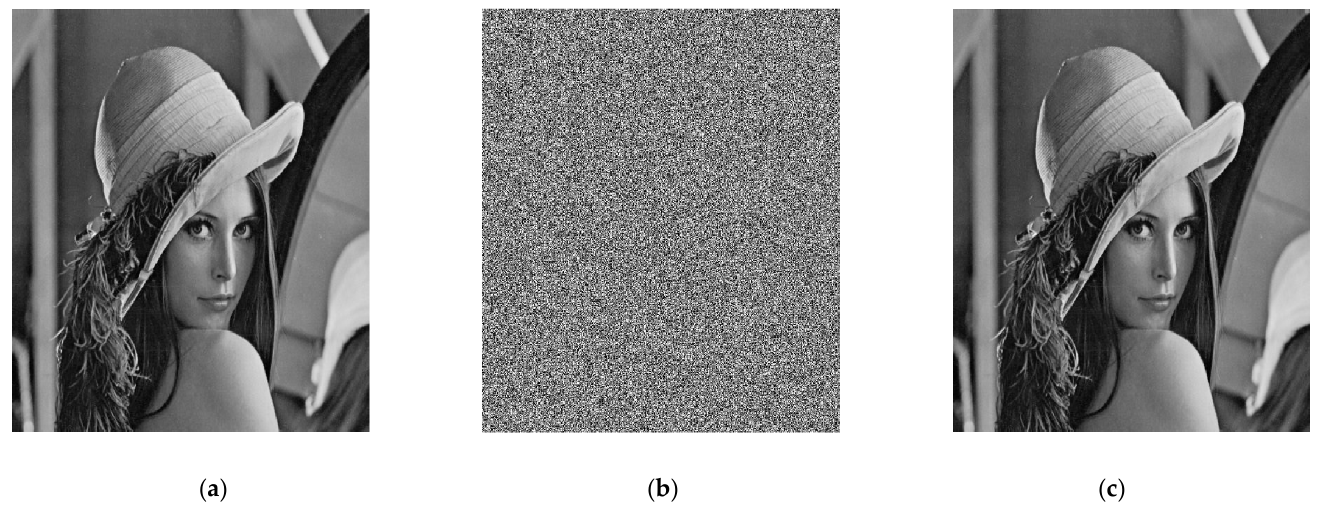
Figure 17. Simulation results of encryption and decryption process of “Lena.png” 512 × 512 grayscale image: ( a ) the original image; ( b ) encrypted image; ( c ) the decrypted image.